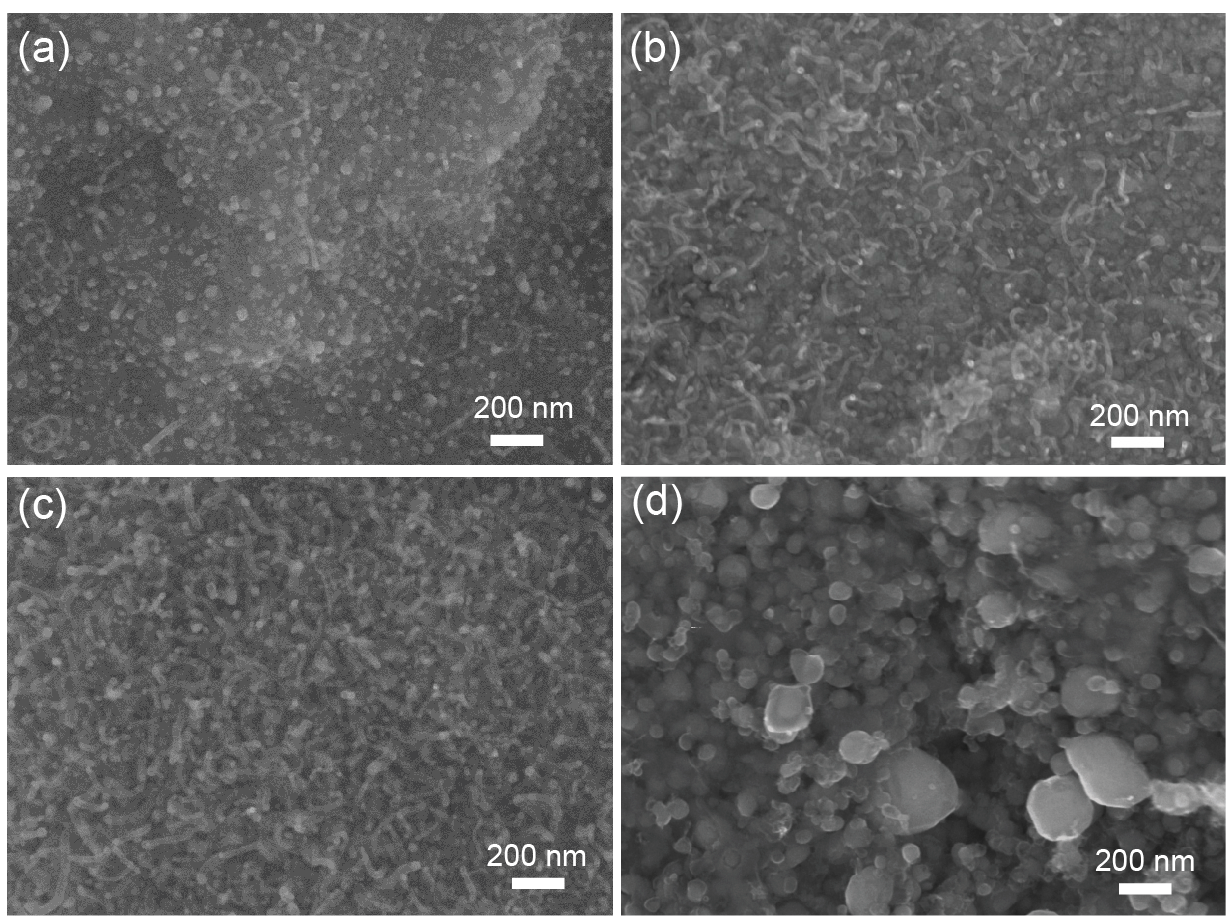
Figure 1. SEM images of ( a ) Co@CNTs-600, ( b ) Co@CNTs-700, ( c ) Co@CNTs-800, and ( d ) Co@CNTs-900. Transmission electron microscopy (TEM) was used to further study the morphology and phase composition of Co@CNTs-800. The TEM image in Figure 2a revealed that the prepared nanotubes were of hundreds of nanometers in length with diameter of ~50 nm, the nanoparticles were formed at the end of the nanotubes and the diameters of the nanoparticles were about 20–60 nm. The high-resolution TEM image (Figure 2b) displayed nanoparticles with spacing of 0.20 nm, which were indexed as the Miller indices (112) of Co. The results revealed that the crystalline Co nanoparticles were embedded in nanotubes, the nanoparticles were surrounded with a carbon layer, and the lattice fringe spacing of the carbon layer was 0.31 nm, assigned to the (002) plane of graphitic carbon [35]. The elemental mapping images in Figure 2c–f indicated that C, Co, and N elements were distributed evenly in the nanotubes. It was noted that more Co elements were concentrated in the nanoparticles region.